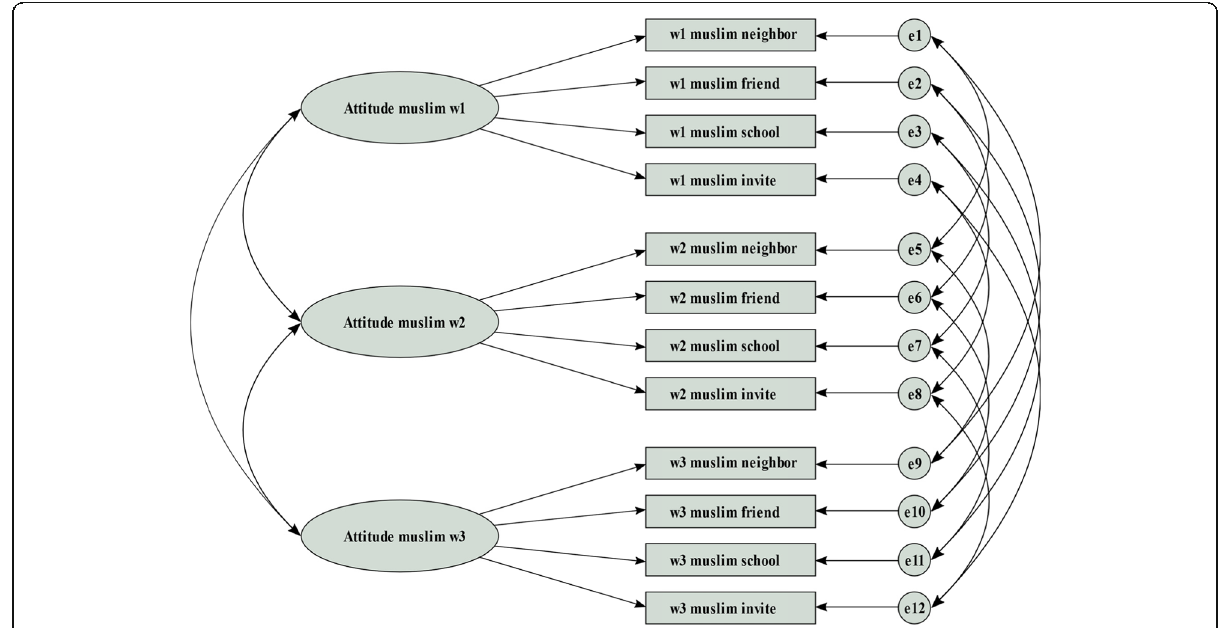
Fig. 2 SCFA for children ’ s attitudes toward Muslim immigrants. Note: w1, w2, and w3 refer to the wave